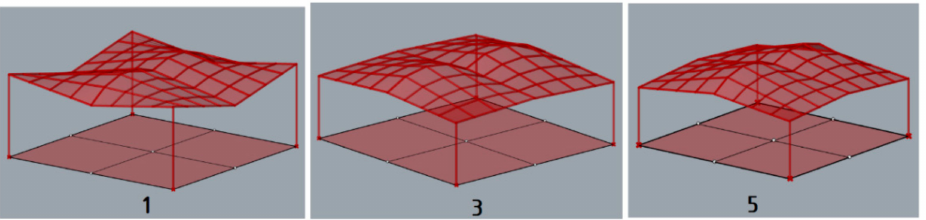
Figure 8. The models of the roof structures composed of conoid units favorable in terms of